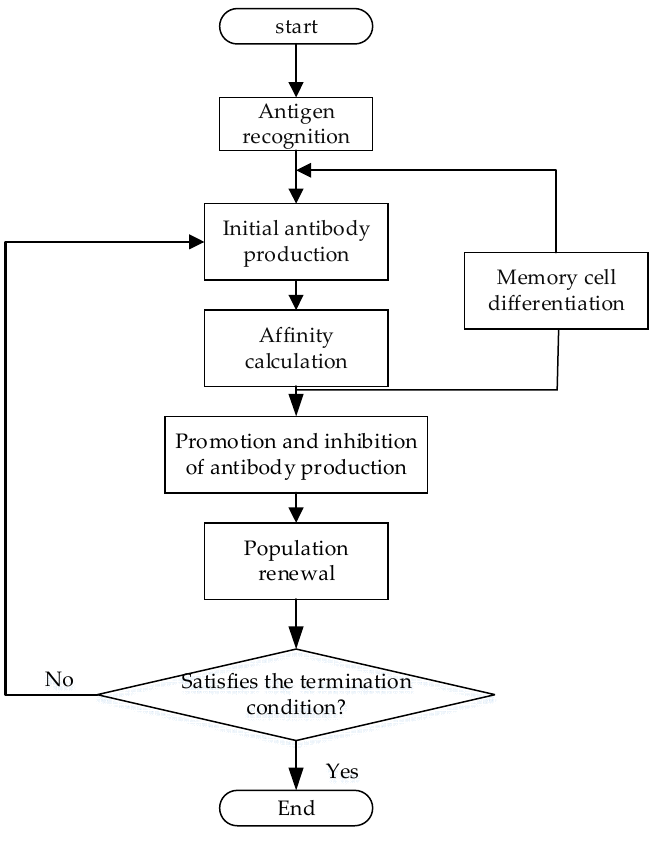
Figure 3. Immune algorithm flow chart.